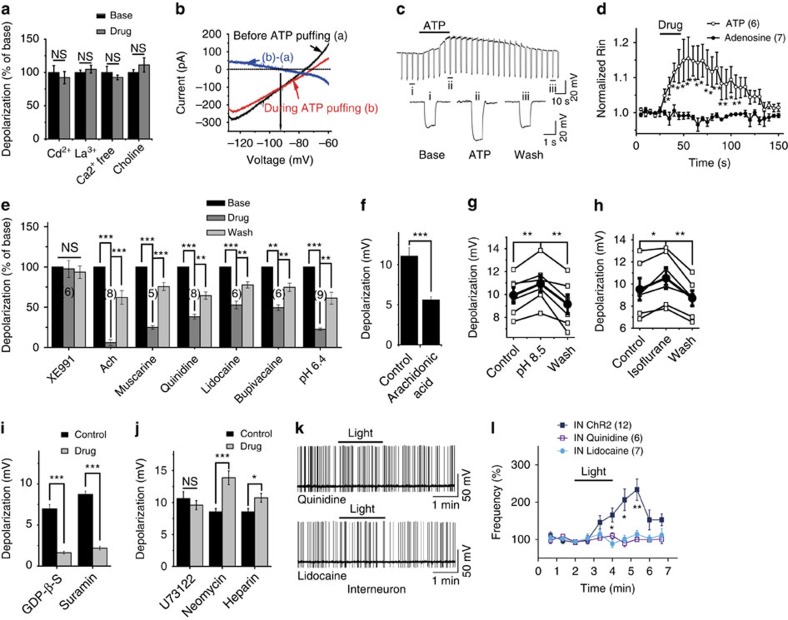
ATP excites CCK-positive interneurons by inhibiting K2P K+ channels.(a) Summary data showing the amplitude of ATP-induced depolarization in the presence of the nonspecific cation channel blockers Cd2+ (Student's t-test, P=0.744) and La3+ (Student's t-test, P=0.193), substitution of extracellular Na+ with the same concentration of choline (Student's t-test, P=0.651) or in the absence of extracellular Ca2+ (Student's t-test, P=0.152). (b) Current–voltage (I–V) curve of ATP-induced inward current determined by subtracting the voltage ramps (from −130 to −60 mV, 10 mV s−1) recorded during ATP puffing from the same ramps recorded at rest. (c) Sample trace showing changes in the interneuron input resistance (Rin) monitored by −50 pA current injections every 5 s before, during and after ATP puffing. (d) Time course of the Rin changes in interneurons during ATP or adenosine application (two-way analysis of variance (ANOVA), F(1,240)=68.78, P<0.0001). (e) Summary data showing the percentage inhibition of ATP-induced depolarization by various K+ channel blockers (Student's t-test, XE991: P=0.32, Ach: ***P<0.0001, ***P=0.0008, muscarine: ***P<0.0001, ***P<0.0001, quinidine: ***P<0.0001, **P=0.0063, lidocaine: ***P<0.0001, **P=0.0069, bupivacaine: **P=0.0015, **P=0.0087, pH6.4: ***P<0.0001, **P=0.0018). (f) Summary data showing the inhibition of ATP-induced depolarization by intracellular application of arachidonic acid (Student's t-test, ***P<0.0001,). (g,h) Summarized data showing aCSF alkalization (pH 8.5, paired Student's t-test, **P=0.0025, **P=0.0036) and isoflurane (100 μM, paired Student's t-test, *P=0.025, **P=0.0022) enhance ATP-induced depolarization. Open squares and filled circles represent individual and averaged depolarization amplitudes, respectively. (i,j) Summary of ATP-induced depolarization amplitude with intracellular application of GDPβs (2 mM, Student's t-test, ***P<0.0001), bath application of suramin (100 μM, Student's t-test, ***P<0.0001), long-term bath application of U73122 (20 μM, Student's t-test, P=0.26) or neomycin (100 μM, Student's t-test, ***P=0.00088), intracellular application of heparin (10 U ml−1, Student's t-test, *P=0.023). (k,l) Sample traces and summary data showing the time course of AP firing frequency before, during and after light stimulation (bar) in the presence of quinidine (open square, two-way ANOVA, F(9,167)=2.78, P=0.0046) or lidocaine (filled circle, two-way ANOVA, F(9,177)=2.78, P=0.0046) in interneurons (IN). NS, not significant.